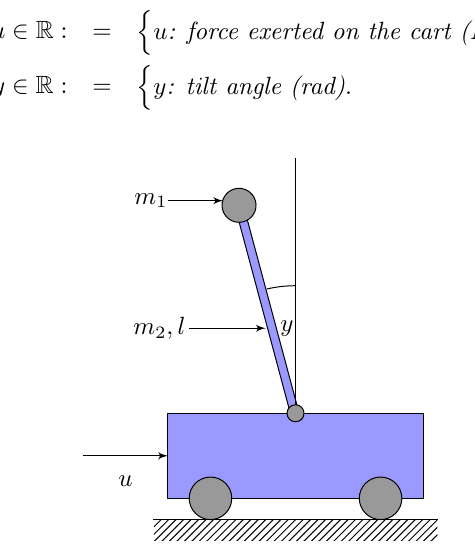
Figure 12: Example 3.7. Schematic model of the in- verted pendulum on a cart, i.e. the plant in the feedback system in Figure 1. Note, that arrows may have different meanings, i.e. la- bels and vector force u . The optimal DIPTD model approximation is given in Table 9 (col. 2). Table 9: Example 3.7. Results from step 2 in Alg. 2.1, i.e. optimal DIPTD model approximation, where c 1 = 0 and c 2 = 10.